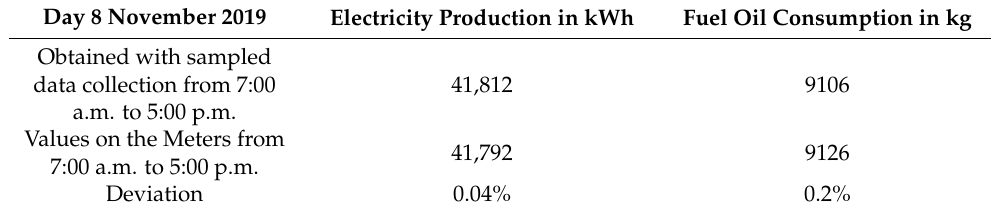
Table 3. Summary of G12 test